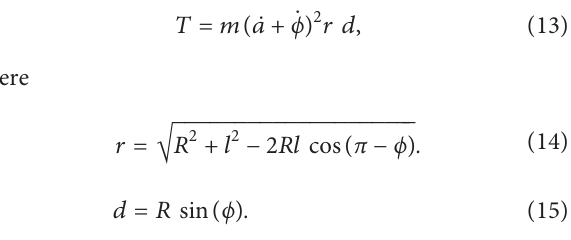
Figure 9: Angular acceleration curves of J engine speed.